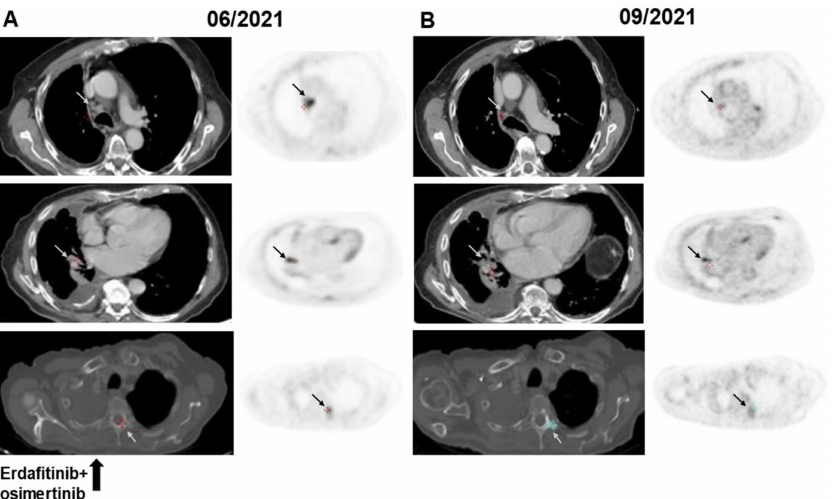
Figure 3. FDG-PET/CT images before ( A ) and during ( B ) therapy with osimertinib + erdafitinib in a patient with an EGFR mutated aNSCLC and FGFR3-TACC3 fusion following progression on osimertinib. Shrinkage of a retro-caval lymph node with a reduction in FDG-avidity, stable lung metastasis with a reduction in FDG-avidity, calcification of a D3 lytic bone metastasis with a reduction in FDG-avidity (gray and black arrows). Abbreviations: aNSCLC—advanced non-small cell lung cancer; EGFR —epidermal growth factor receptor; FDG— fluorodeoxyglucose ; FGFR3-TACC3 —fibroblast growth factor receptor 3-transforming acidic coiled-coil-containing protein 3; PET/CT— positron emission tomography /computer